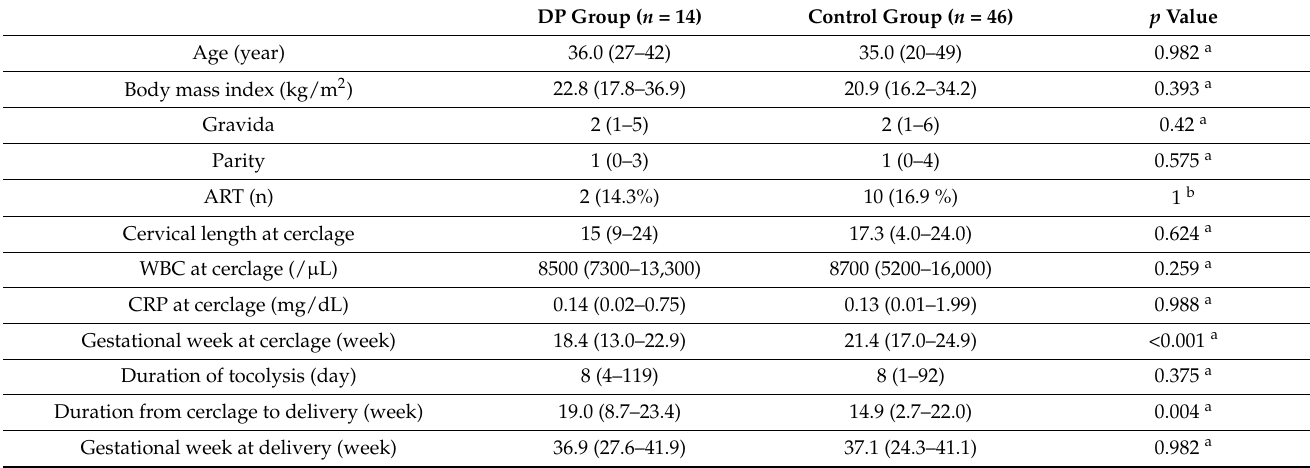
Table 1. Comparisons of maternal characteristics and cerclage outcomes between the study groups.